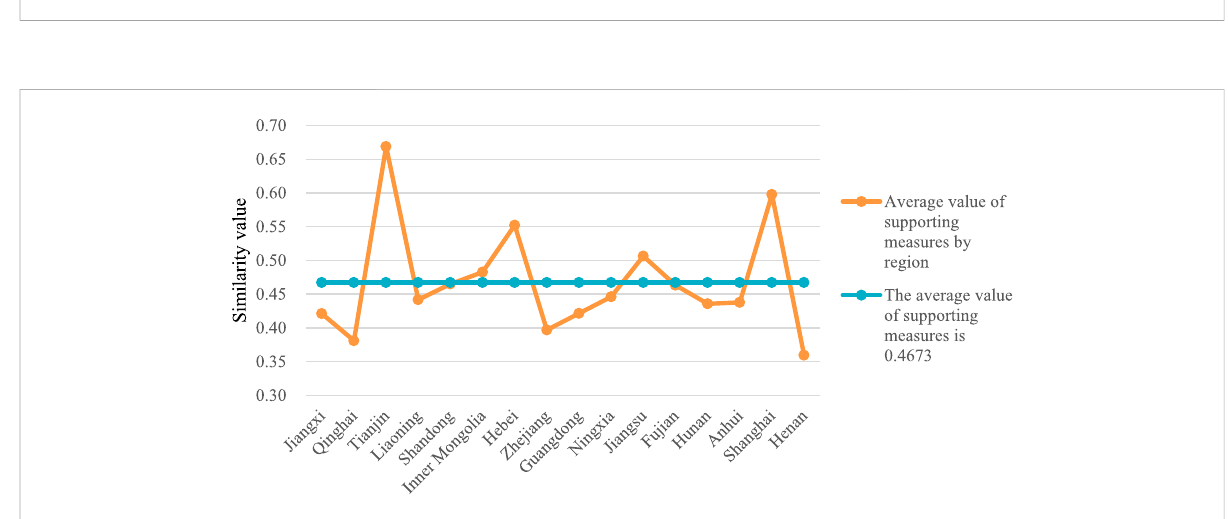
FIGURE 5 Average similarity of supporting measures of different